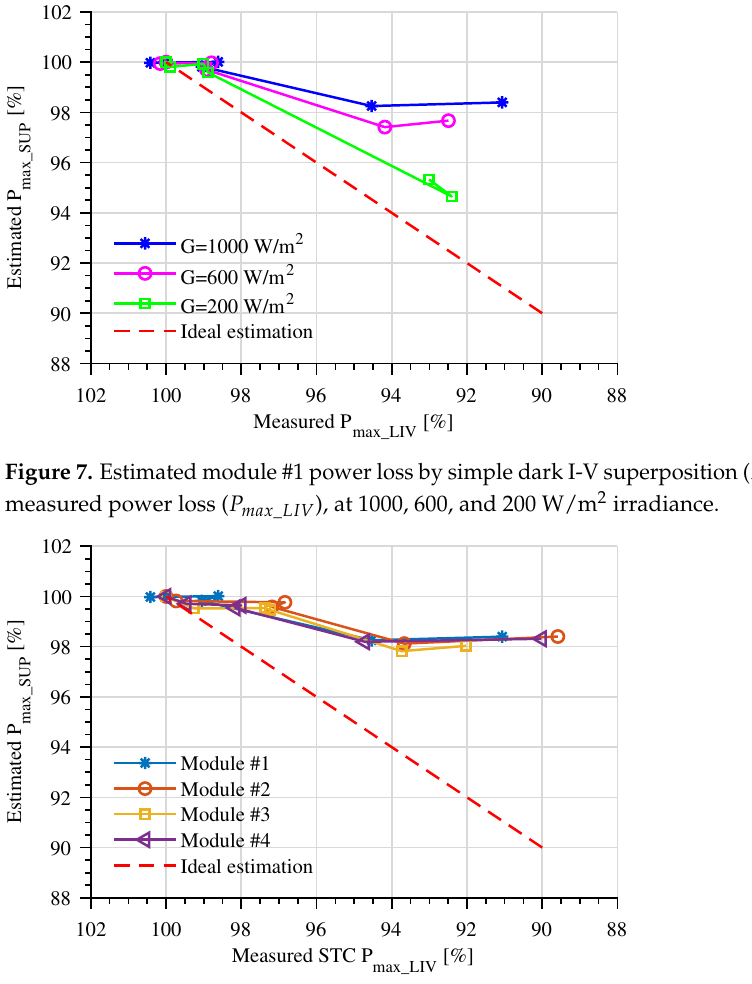
Figure 8. Comparison of estimated module power loss by simple dark I-V superposition ( P max _ SUP ), versus measured STC power loss ( P max _ LIV ), for all four